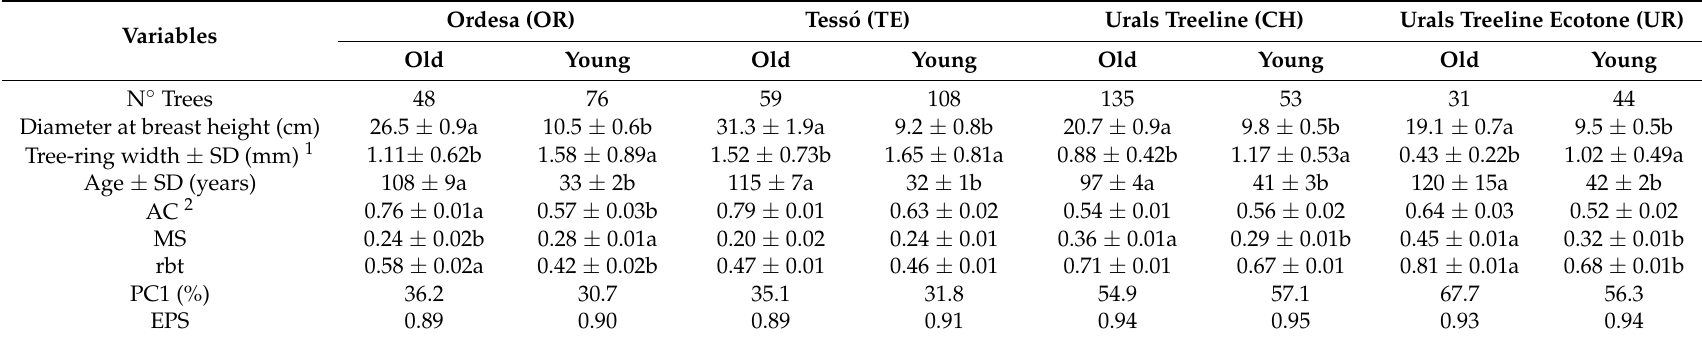
Table 2. Dendrochronological statistics calculated for the ring-width chronologies of each age group (old vs. young trees) for the period 1950–2012. Data are means ± standard